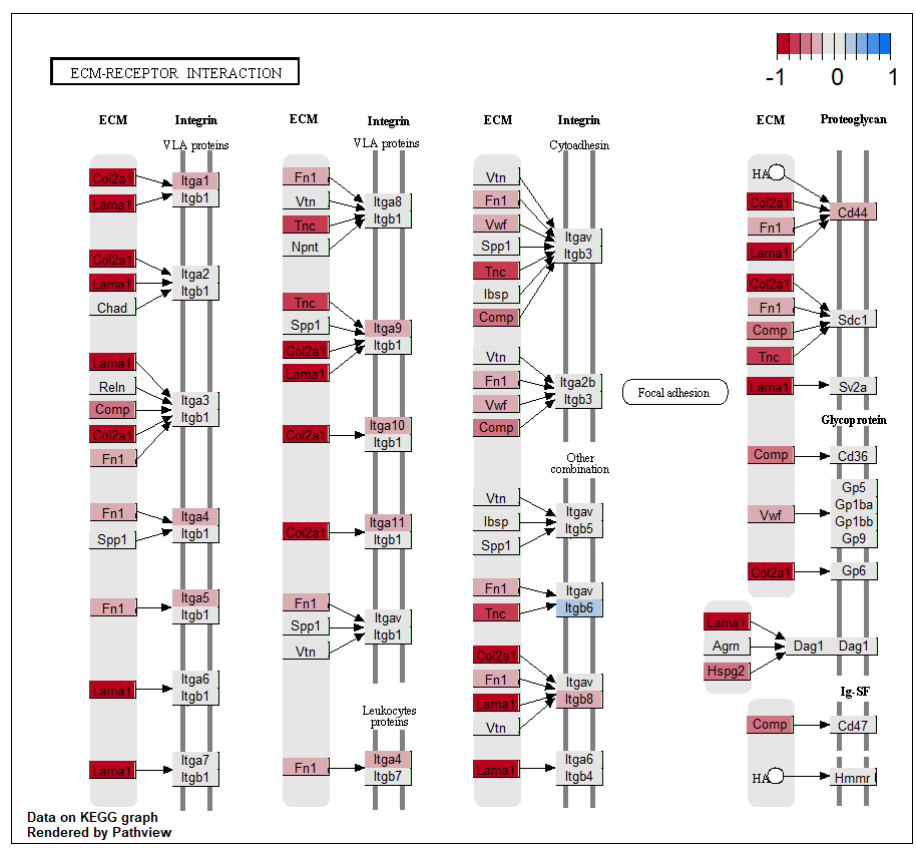
Figure 4. KEGG pathway ‘ECM-receptor interaction’ with significant changes in gene expression.